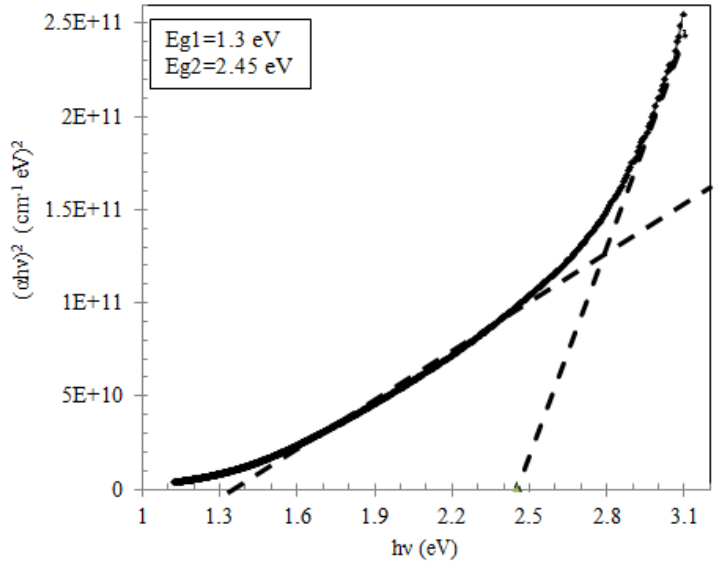
Figure 3: (  h    calculated as a function of energy h  for FeS 2 